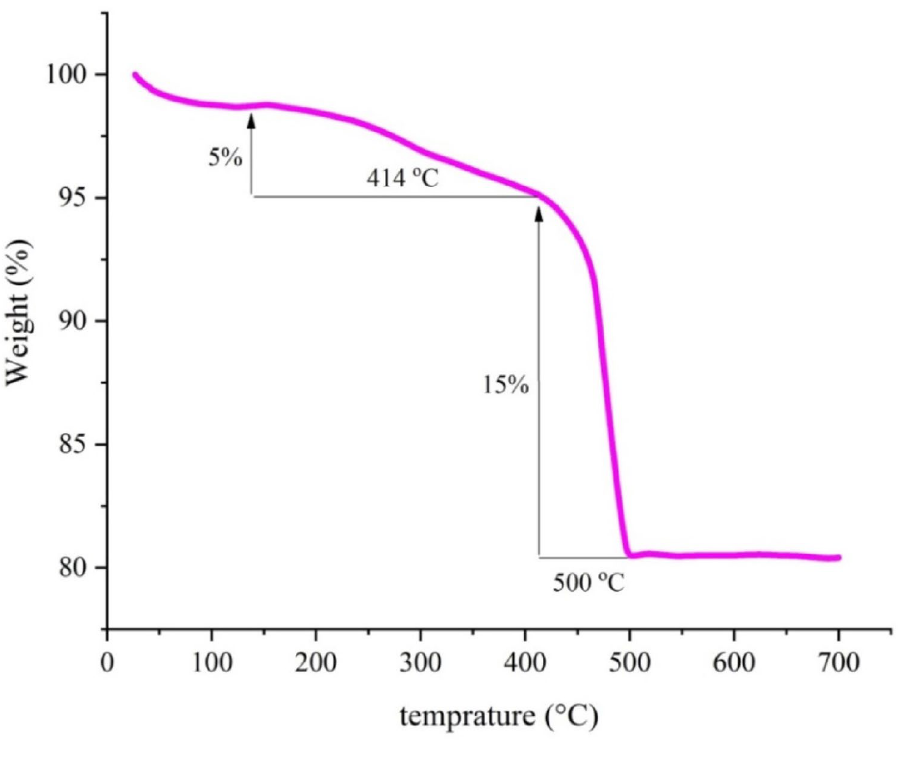
Figure 10. TGA of Fe 3 O 4 @SiO 2 -Im[Br]-SB-Cu (II) nano-catalyst.